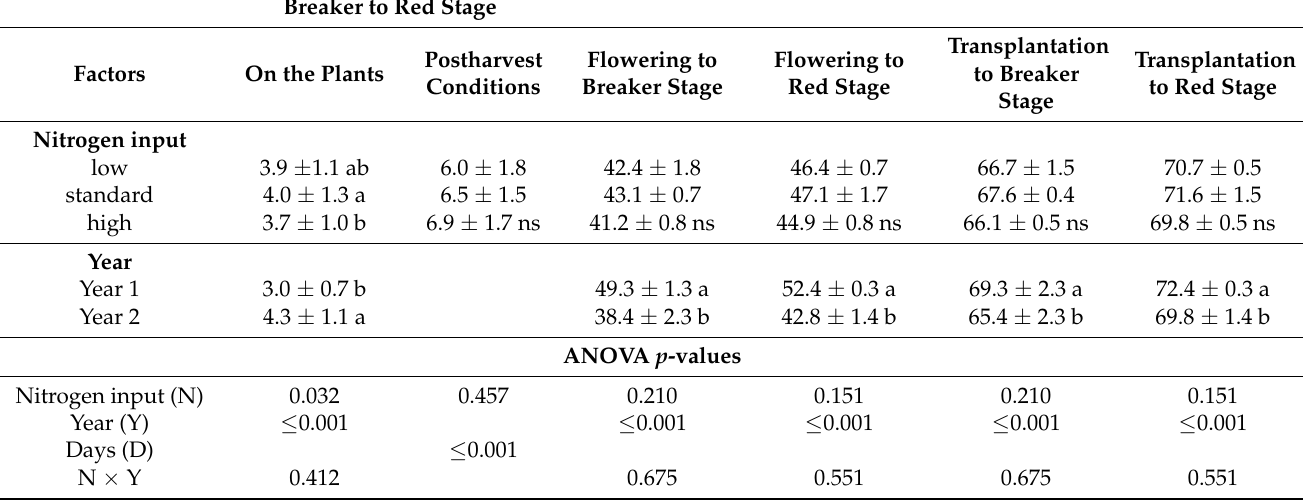
Table 1. Analysis of variance (ANOVA) of the number of days from the breaker stage to the red stage both on the plants and at postharvest conditions, and of the days from flowering and transplantation until the breaker and red stages in Years 1–2.